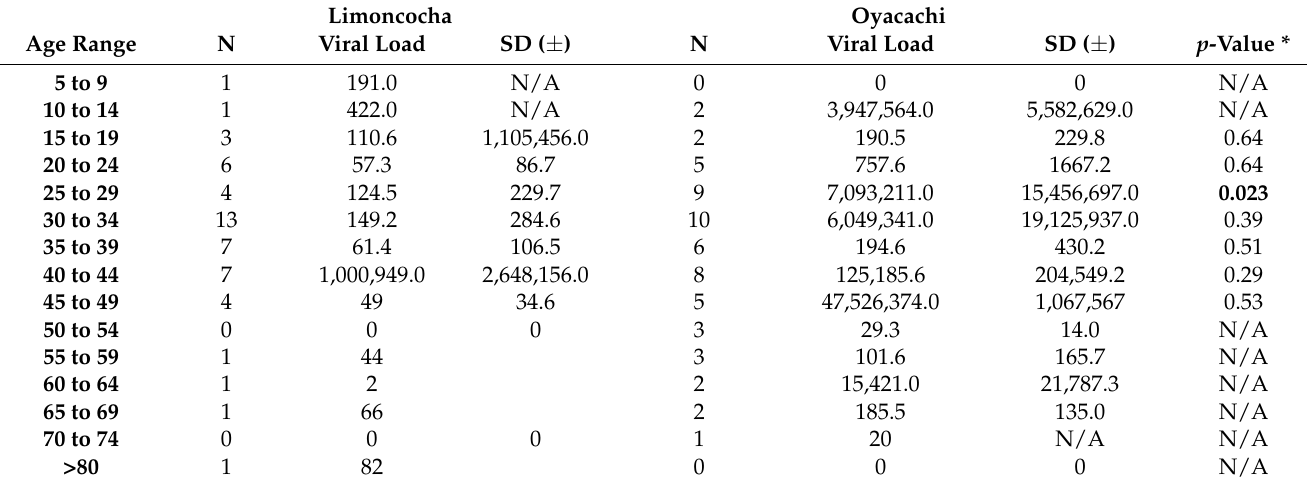
Table 1. Viral loads composition across age groups among 108 positive tests for SARS-CoV-2 infection.